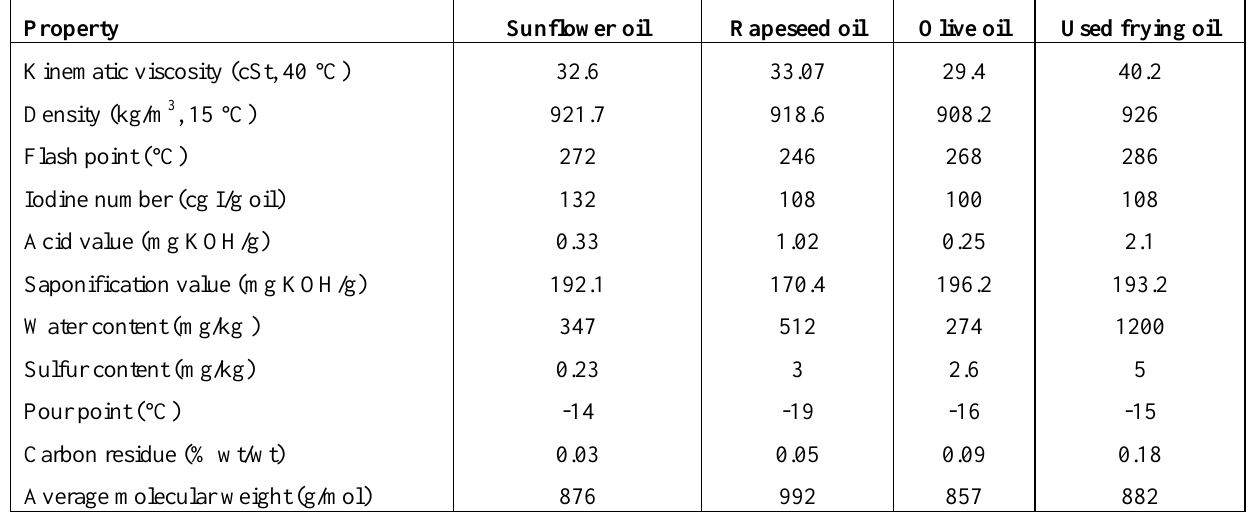
Table 1. Physicochemical properties of vegetable